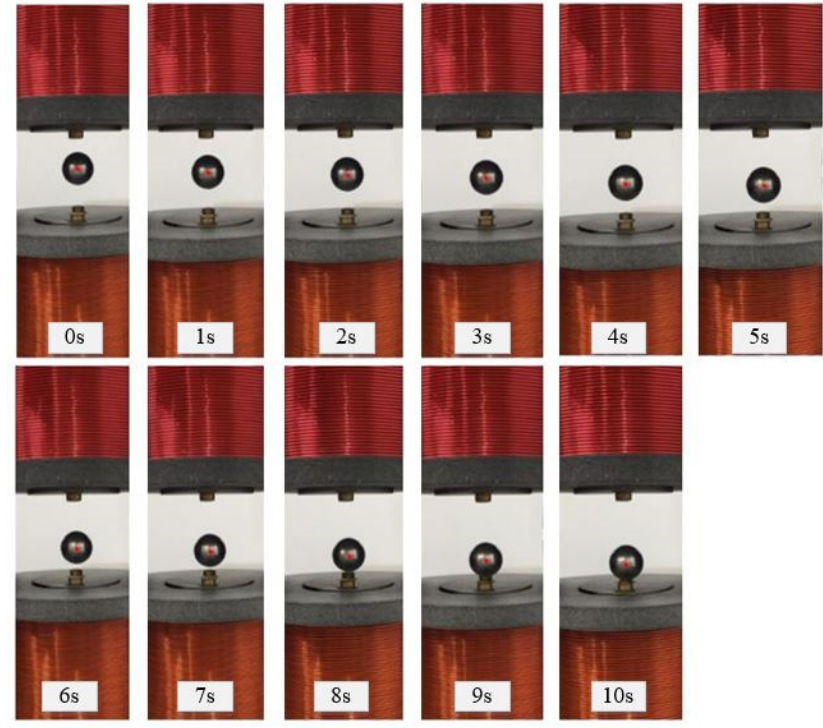
Figure 14. Levitating motion effect during descending motion.